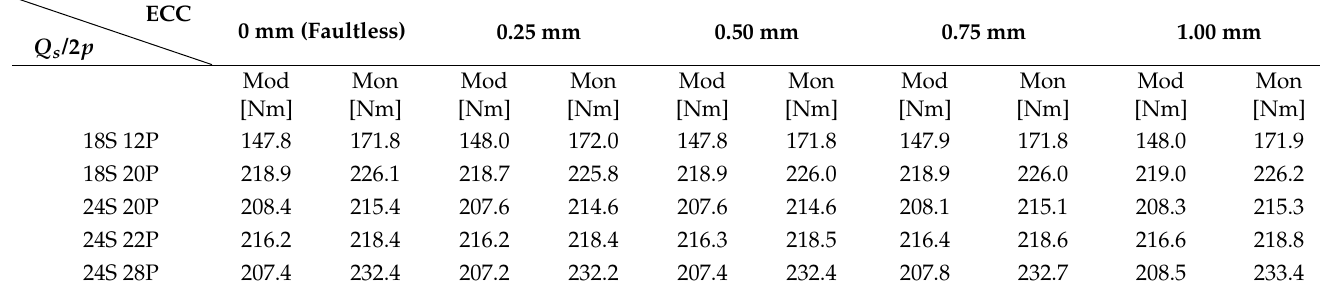
Table 18. Mean torque of different PMSM and MPMSM slot/pole combinations in the presence of DE.